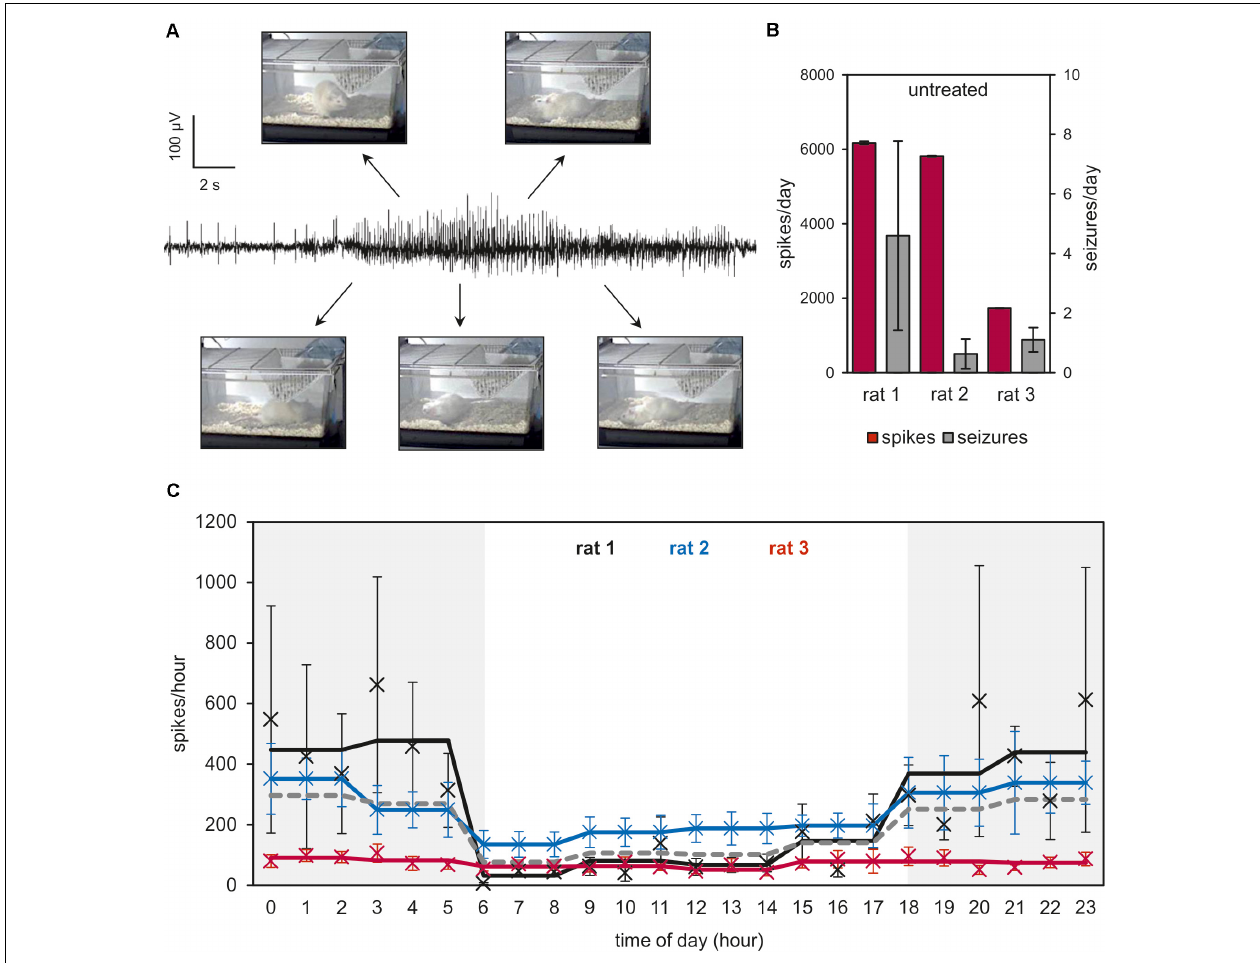
FIGURE 1 | Video-EEG analysis of F98 glioma-bearing Fischer 344 rats. Single-channel electrodes were implanted epidurally to record an EEG trace of F98 glioma-bearing Fischer 344 rats for the whole time of the animal experiments. Rats were housed in individual cages with 12-h light/dark cycles (illumination: 6:00–18:00 h). (A) Sample trace of a representative seizure. Photos illustrate the association of field records with motor expressions during seizure. More details of ictal potentials are shown in Supplementary Figure 3 . (B) The last 9–2 days (relative to sacrifice) in the life of the animals were analyzed and seizures were counted for each animal individually. (C) Number of spikes and distribution over time of day are shown as means ± SEM (5–9 data points per time of day). Means of 3-h-intervals are presented as lines. Gray-shaded areas indicate time of day without illumination in the animal housing facility. The dark gray dotted line represents mean of 3-h-intervals of all three